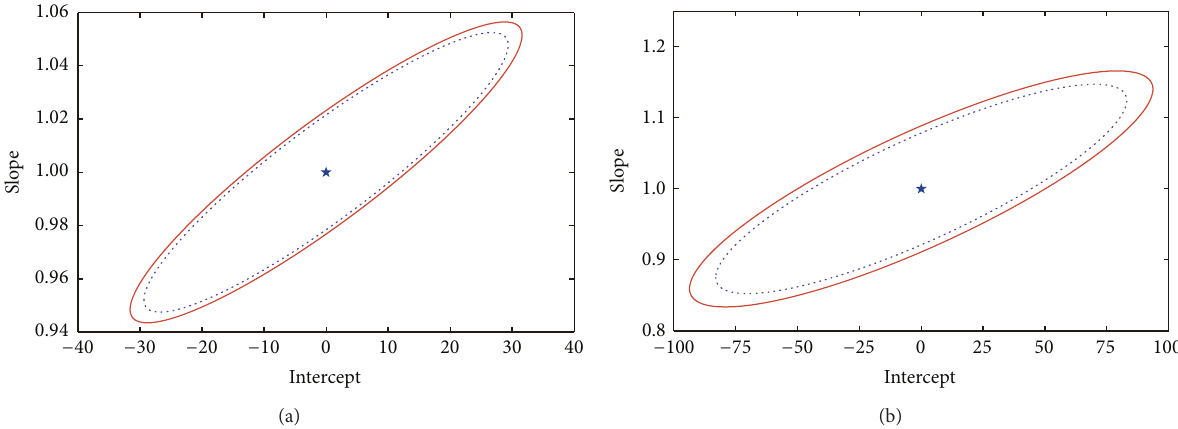
Figure 6: EJCRs for valsartan (a) and amlodipine besylate (b) by applying PARAFAC and ATLD with 𝑁 = 2 . The pentacle ( 󳀅 ) indicates the ideal points (0, 1). The solid lines and dotted lines correspond to the EJCRs in human plasma by applying ATLD and PARAFAC, respectively. Table 6: Intra- and interaccuracy and precision of valsartan and amlodipine besylate using two algorithms. Analytes Algorithms